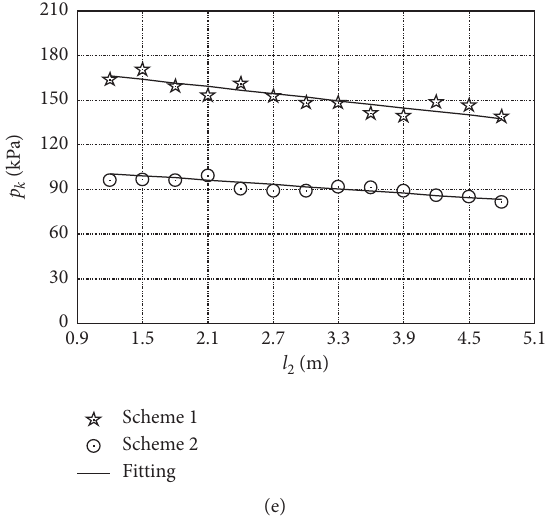
Figure 9: Relation between (p) k and kitchen parameters. (a) Width. (b) Length. (c) Height. (d) Opening. (e)